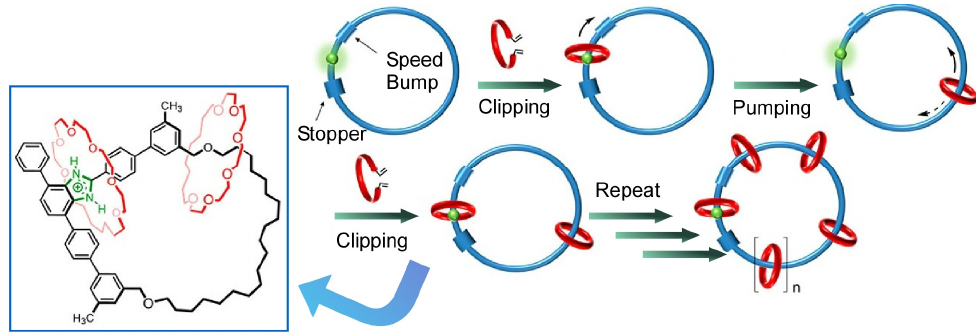
Figure 5. Controlled synthesis of radial [n]catenanes as molecular necklaces through clipping-followed-by-pumping. Reprinted with permission from Reference [131]. Copyright 2022 American Chemical Society.